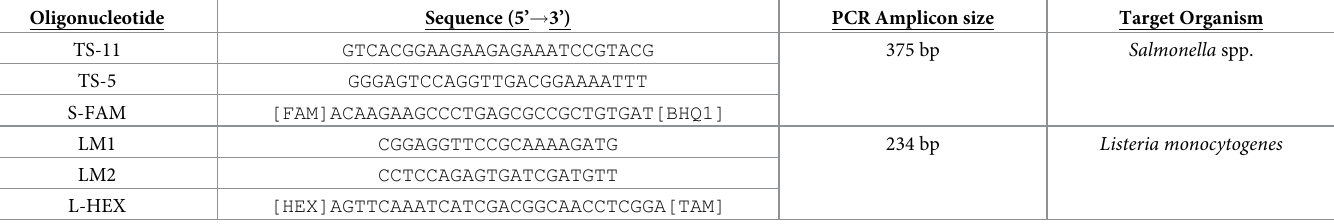
Table 2. Primers and probes used in multiplex real time PCR assay for a) confirmation of presumptive Salmonella spp and L . monocytogenes based on Kawasaki et al. (2010).